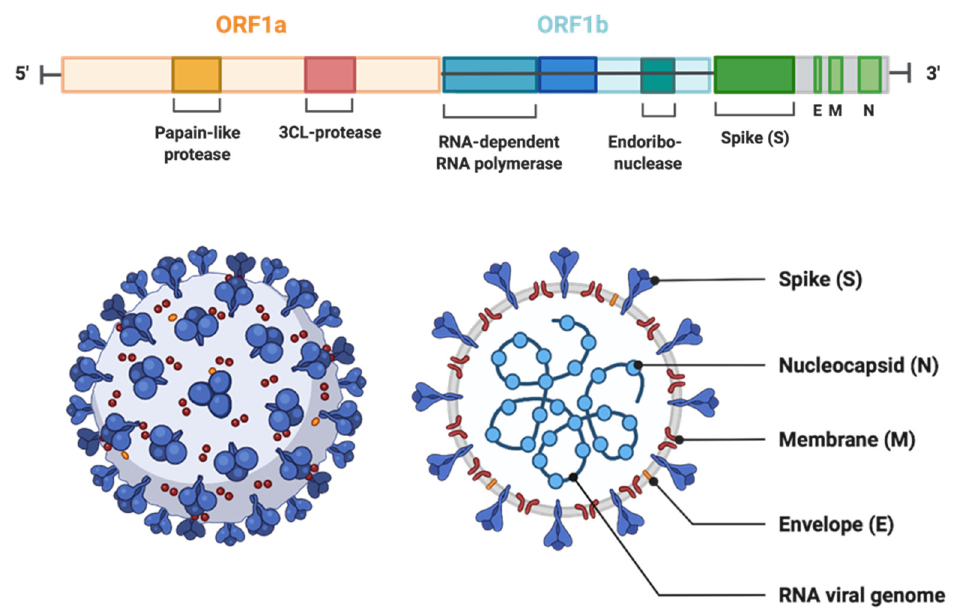
Figure 1. The genomic organization of SARS-CoV-2. The genome encodes two large genes ORF1 (yellow) and ORF1b (blue), which encode nonstructural proteins. These nonstructural proteins encode for papain-like protease (PLP), 3CL-protease, RNA-dependent RNA polymerase, and endoribonuclease. The structural genes encode the structural proteins, spike (S), envelope (E), membrane (M), and nucleocapsid (N) (highlighted in green). (The Figure is created with Biorender.com.)